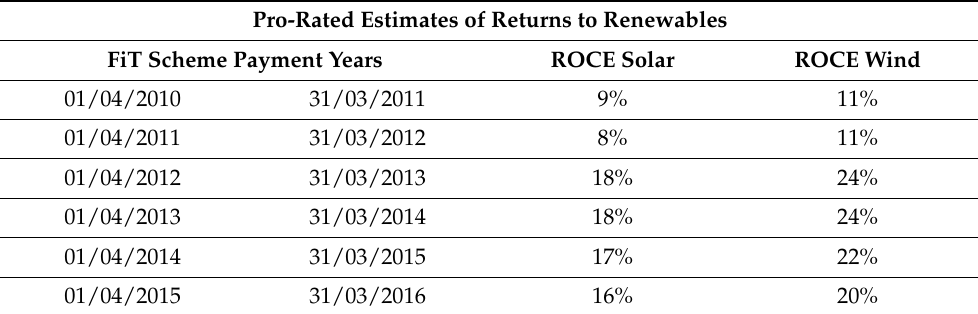
Table 4. Investor income per MW of capacity plus return on capital (source: authors’ calculations).